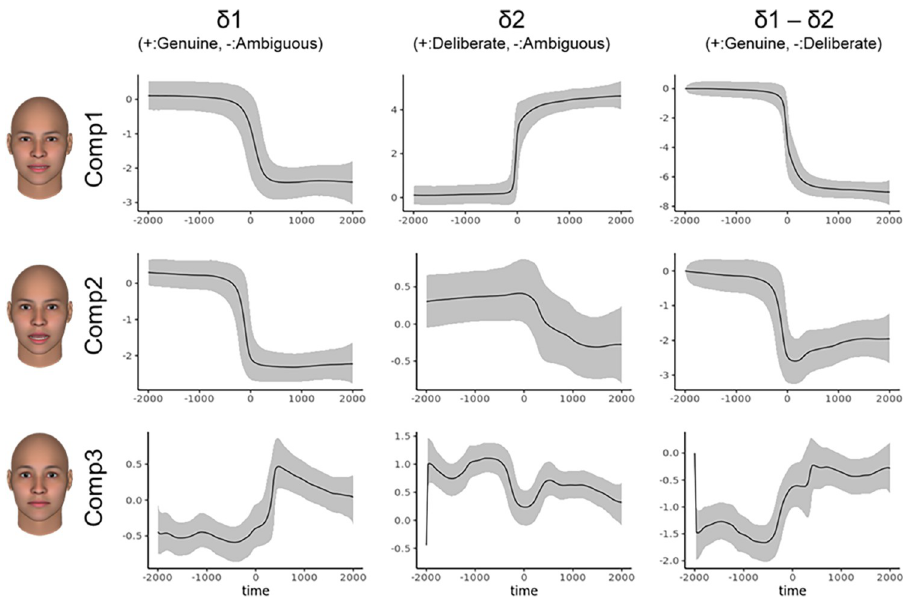
Fig 5. Time-series patterns for the magnitude of difference between the perceived-as-genuine and perceived-as- deliberate expressions of anger. The y-axis represents the extent of the “ δ ” parameter for each component. The solid lines indicate the expected a posteriori. Positive values refer to a relatively large spatial component of (left: perceived- as-genuine, center: deliberate, right: genuine), while negative values indicate a relatively large spatial component of (left and center: perceived-as-ambiguous, right: deliberate). The ribbons represent 99% credible intervals.